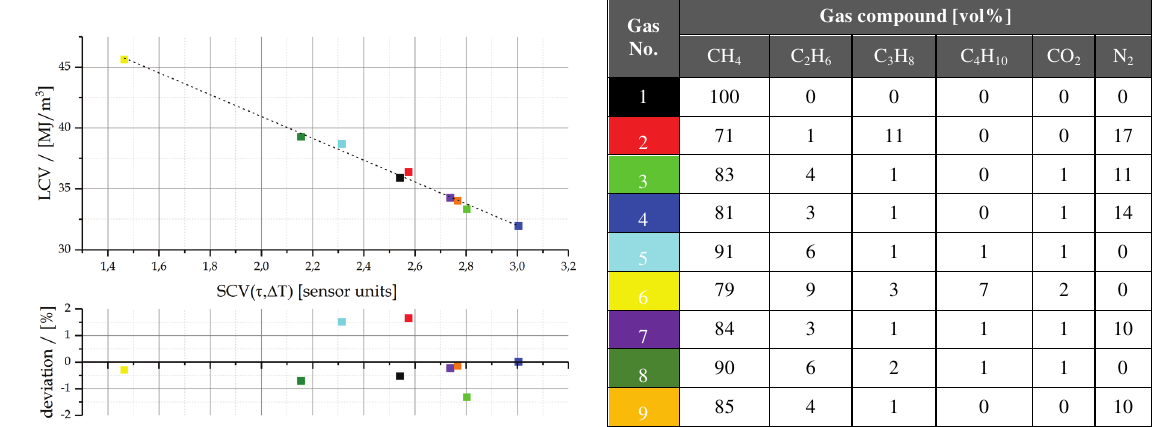
Fig. 6. Result of the theoretical correlation for the lower calorific value over a set of gas blends